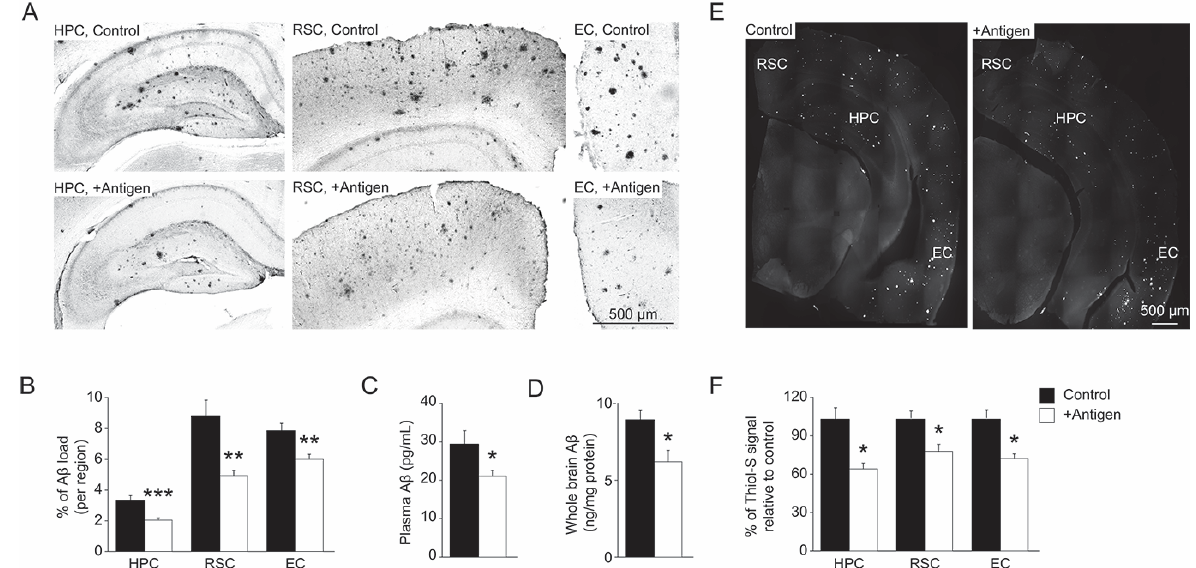
Figure 4. Reduction of A β 42 in blood-plasma and brain, and reduction of amyloid plaque burden in brains of antigen-injected mice. ( A ). Hemisphere brains of post-mortem mice (control and antigen- immunized) were dissected, and immunohistochemistry analyses were performed to detect A β 42 , according to the procedure described under the Section 2. The data shows a decline in the levels of A β 42 in the three brain regions (HPC, hippocampus; RSC, retrosplenial cortex, and EC, entorhinal cortex) of the antigen-immunized as compared with the control mice. ( B ). Quantification of the data presented in Panel A using NIH-Image J program. Quantification of A β 42 in blood-plasma ( C ) and post-mortem brain extracts ( D ) of antigen-injected and control mice using ELISA kit according to the procedure described under the Section 2. ( E ). Thioflavin-S staining of the post-mortem mouse brains according to the procedure described under the “Materials and Methods” section. Lower plaque-burden was observed in the antigen-injected versus control mice. ( F ). Quantification of the data depicted in panel E using NIH Image-J program. In all of the graphs, black and white bars represent control and antigen-injected mice, respectively. Standard deviation is shown for each averaged bar. Data were acquired from all tested mice for panels C and D ( n = 9 per each group of mice) and five mice per each tested group of mice for panels B and F. Statistical analyses were performed using two-tailed student t -test with the following p values: *, p < 0.05; **, p < 0.01, and ***, p <